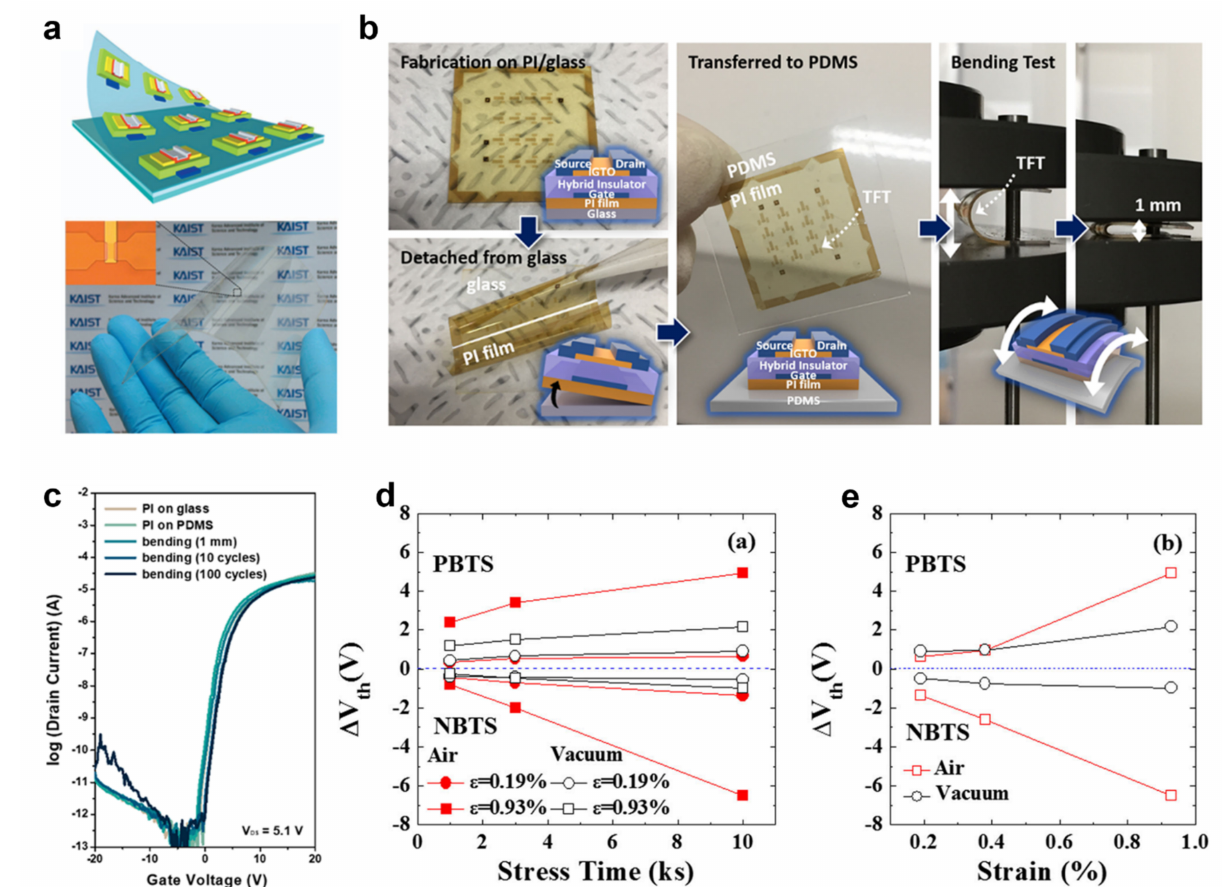
Figure 2. ( a ) Schematic diagram of the flexible device structure and optical image (adapted from [53] with permission from Springer Nature); ( b ) Image of the IGTO TFTs and their bending test procedure; ( c ) Transfer characteristics for the IGTO TFTs (adapted from [56] with permission from American Chemical Society); ( d ) BTS (VGS = ± 20 V at 60 ◦ C) time evolution of the threshold voltages for the ε = 0.19% (circle) and 0.93% (square) cases in a vacuum and air ambient; ( e ) Vth shift after 10,000 s BTS for different strain and ambient conditions (adapted from [57] with permission from Taylor &